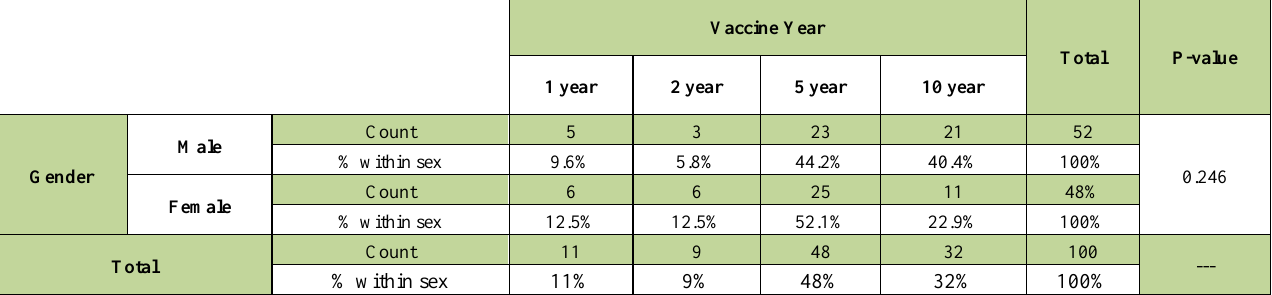
Table 5. Frequency of samples in terms of time of receipt of the vaccine by gender.